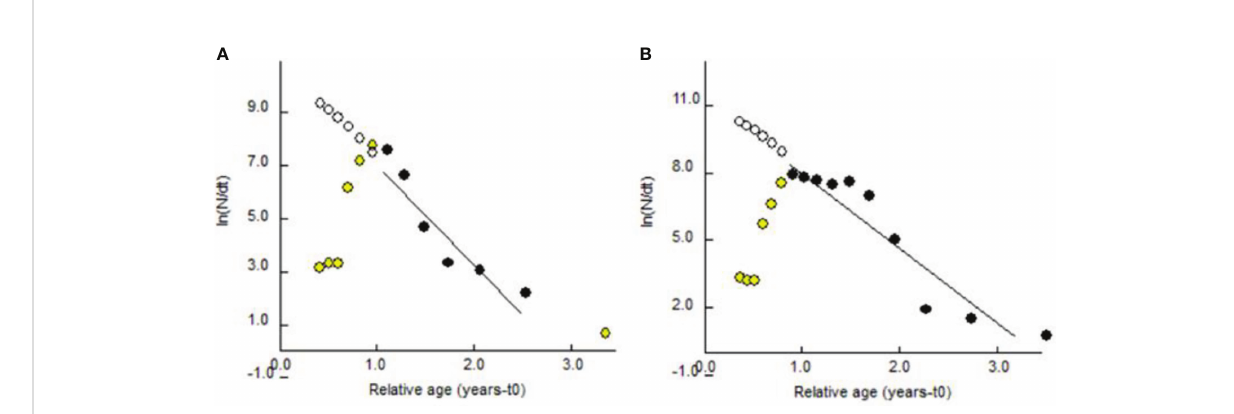
FIGURE 15 Length-converted catch curve of (A) male and (B) female P. elegans from the southeast Caspian Sea (2019 –